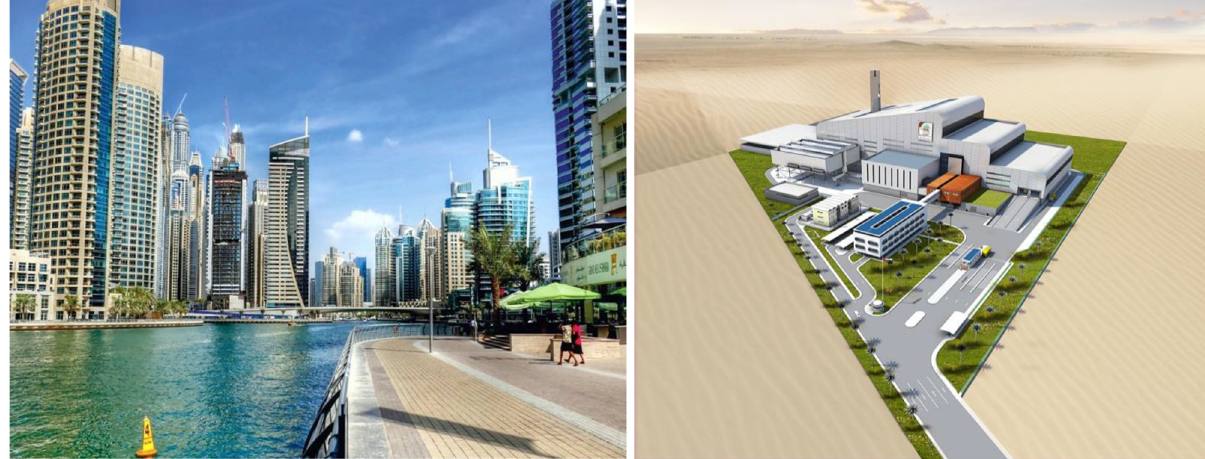
Fig. 13. UAE typical buildings and the world ’ s largest energy from waste plant built in the Emirate of